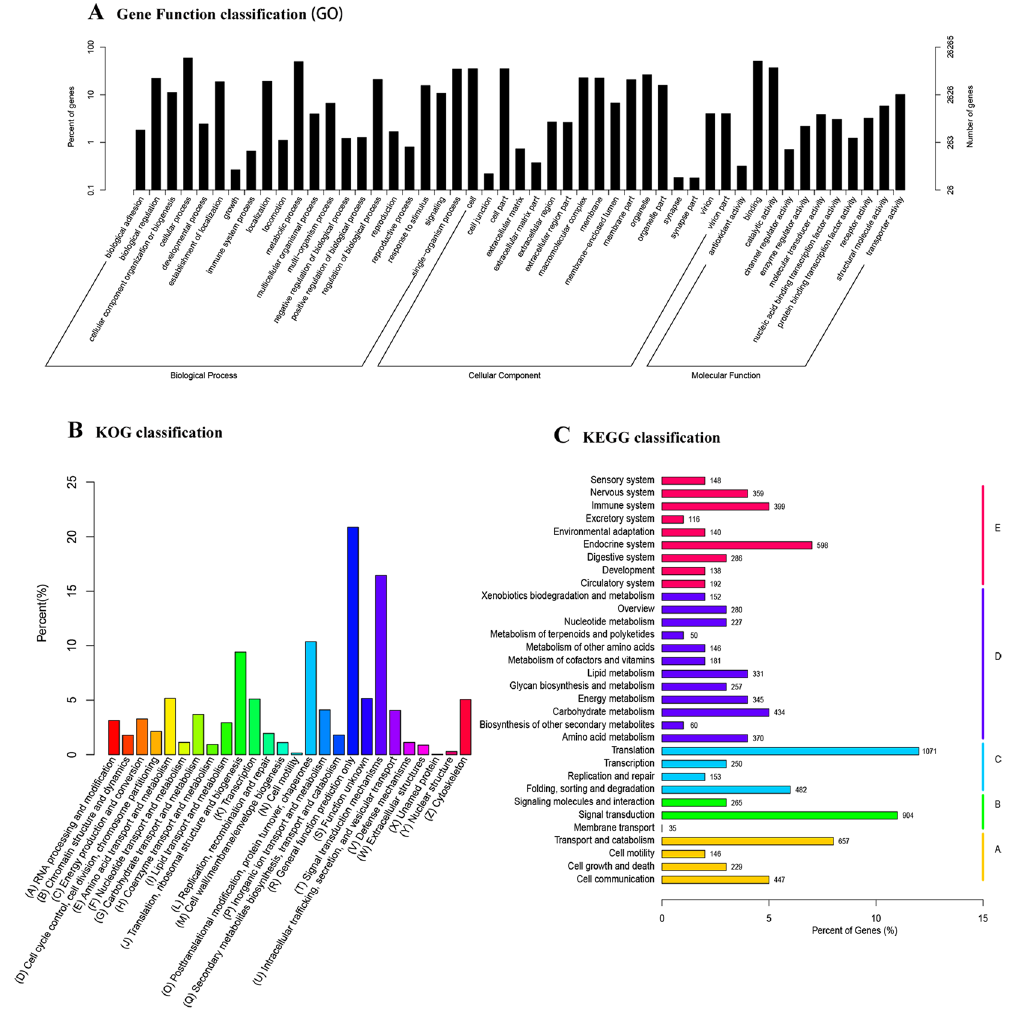
Figure 2. Gene ontology (GO), Clusters of Orthologous Group (COG) and Kyoto Encyclopedia of Genes and Genomes (KEGG) classification of all unigenes. ( A ) The GO classification results summarized in three main GO categories (cellular component, molecular function, and biological process). The x-axis represents the GO ontology. The left y-axis indicates the percentage of unigenes. The right y-axis indicates the number of unigenes. ( B ) COG classification of all unigenes. The columns represent the number of unigenes in each subcategory. ( C ) KEGG classification of all unigenes. The columns represent the number of unigenes in each